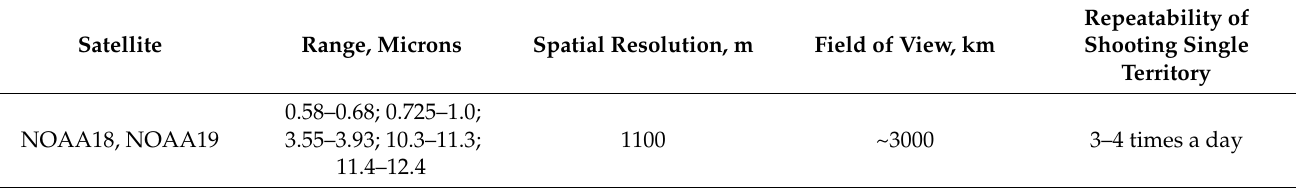
Figure 2. Example of a thermal point.